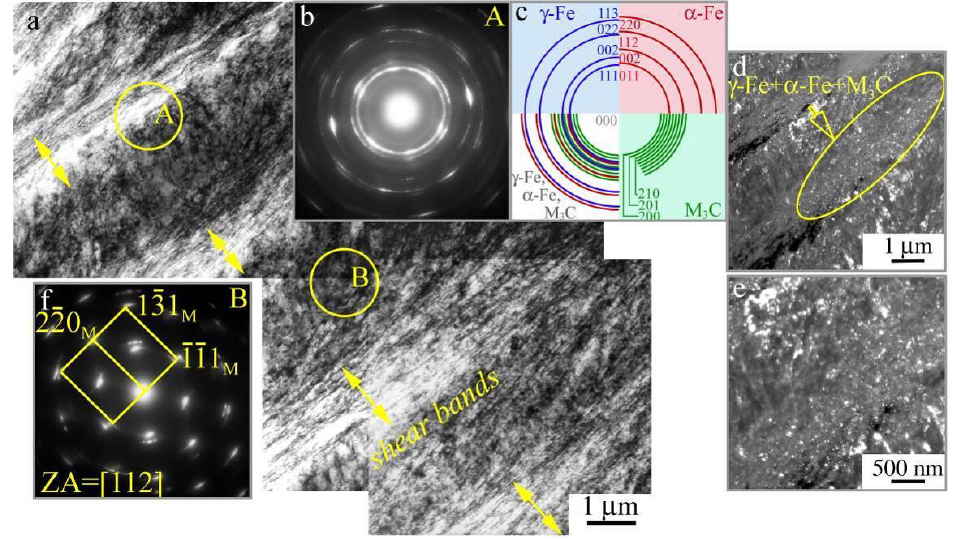
Figure 2. TEM bright-field ( a ), dark-field ( d , e ) images of microstructure in Fe-13Mn-1.3C steel after HPT 400 (N = 5) and corresponded to the SAED patterns ( b , f ) with interpretation ( c ). Dark-field images ( d , e ) were obtained in combined reflections of γ - Fe, α -Fe, and M 3 C. Image ( e ) is a magnified area in image ( d ) corresponded to the yellow oval. SAED patterns probed area is 1.4 μm 2 .